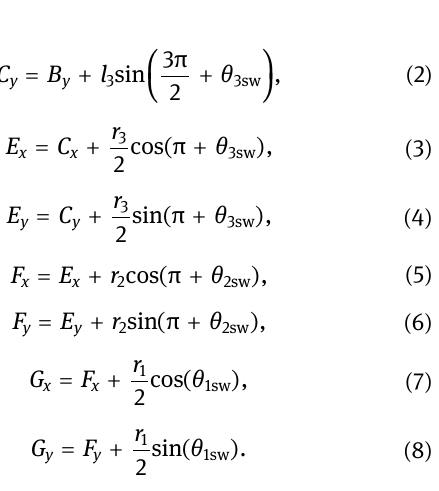
Figure 1: LLE during a gait cycle; ( a ) swing phase and ( b )